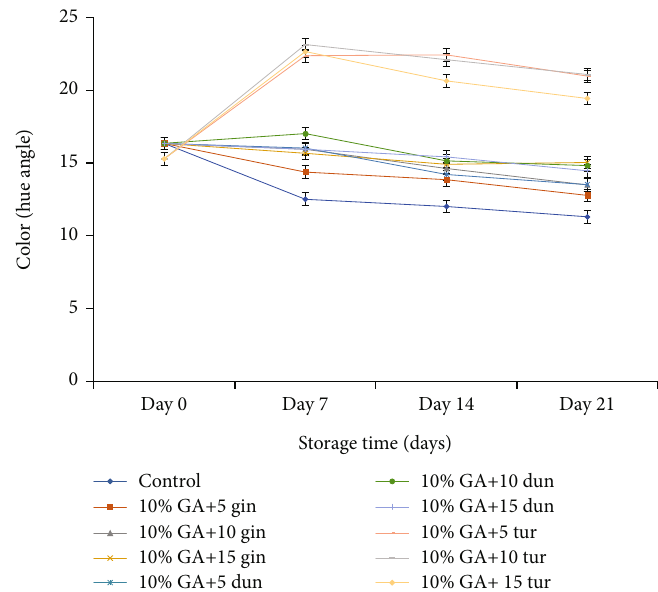
Figure 8: E ff ect of 10% GA incorporated with plant extracts at di ff erent concentrations on color development during cold storage for 21 days.